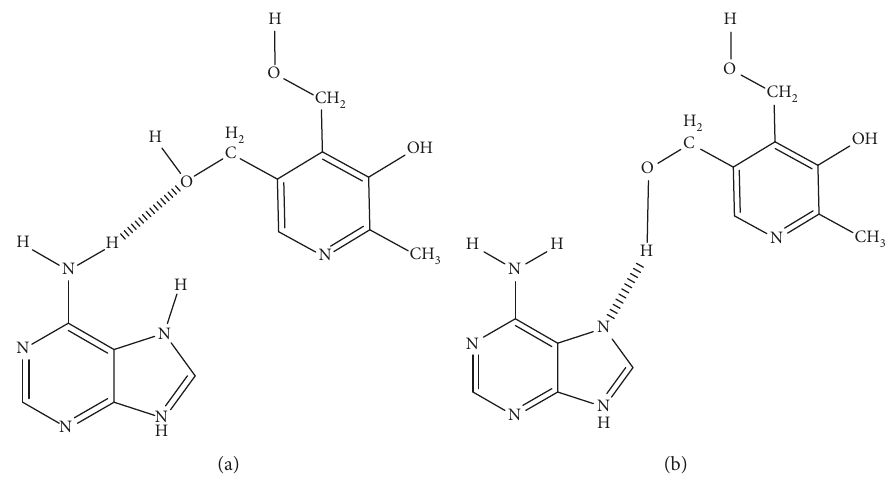
Figure 11: Proposed chemical structures of adenine-pyridoxine